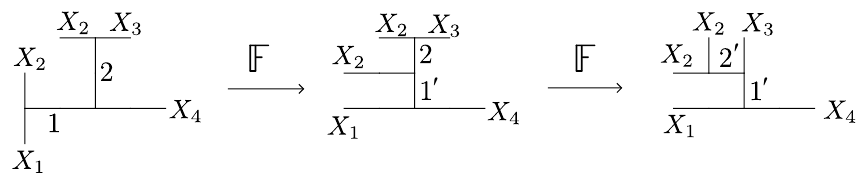
Figure 7 . Sequence of crossing transformations that simplify the five-point